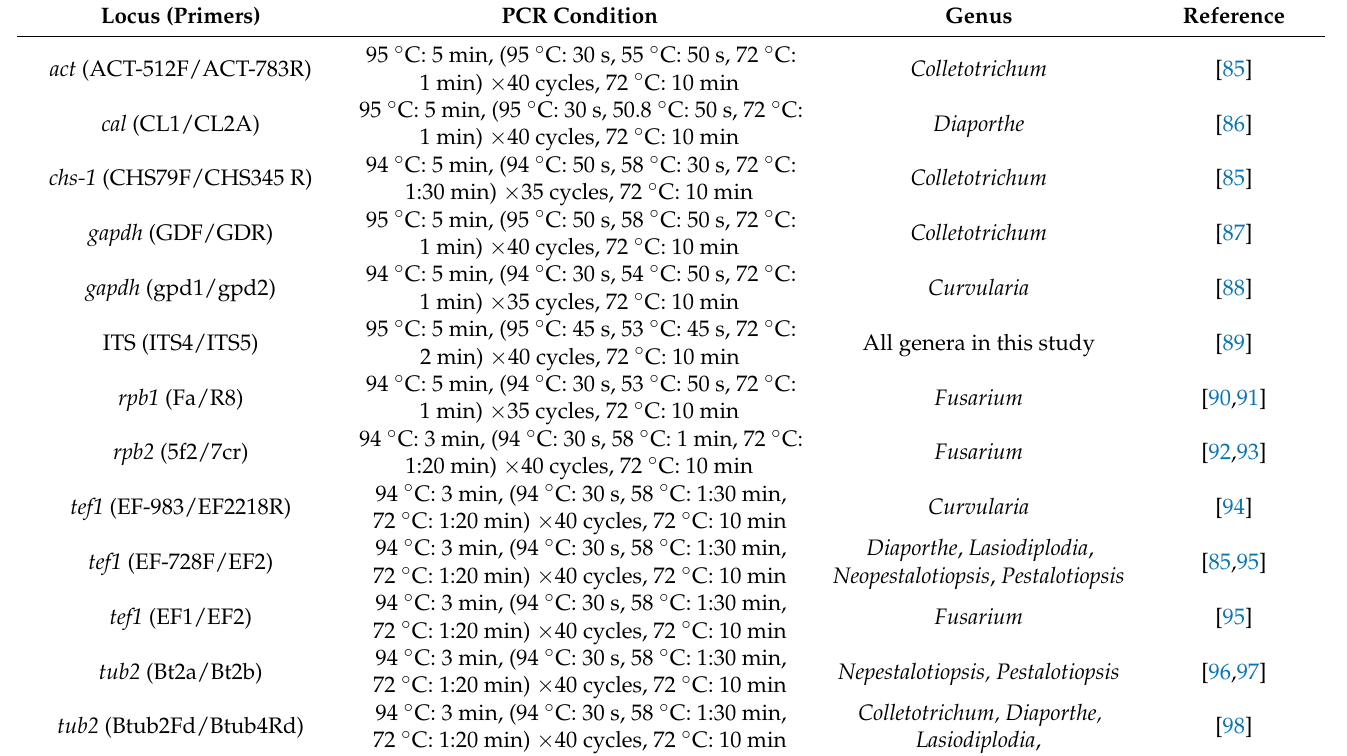
Table 2. PCR conditions and used primers in this